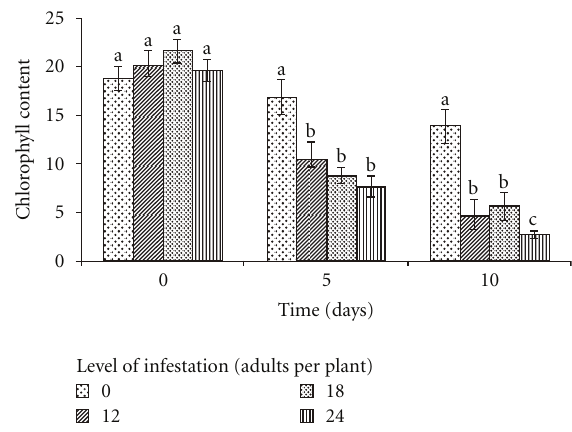
Figure 2: Relationship between chlorophyll content (SPAD unit) of B. ruziziensis and exposure time (0, 5, and 10 days) at di ff erent infestation levels of adult M. spectabilis . Mean values followed by the same letter within the levels of infestation did not di ff er by Tukey